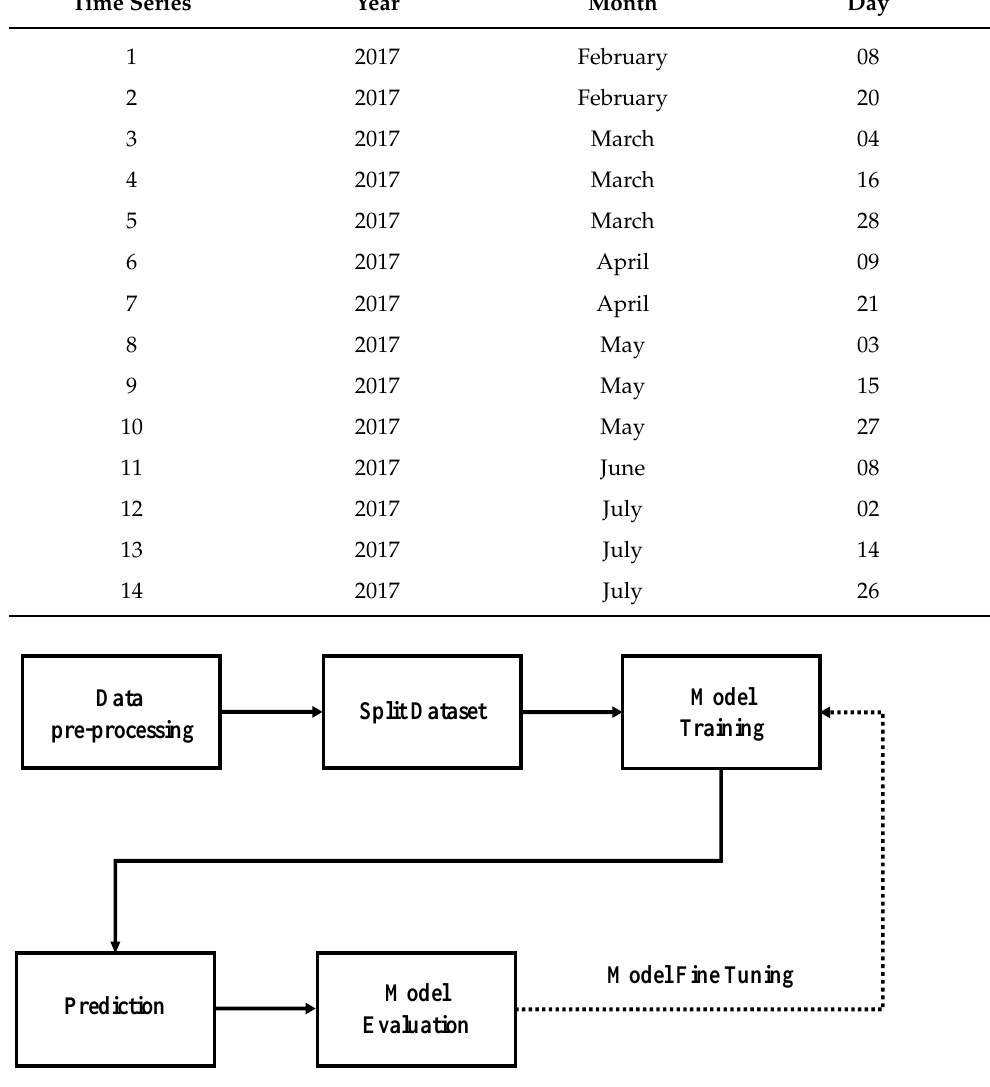
Figure 3. Flowchart of this